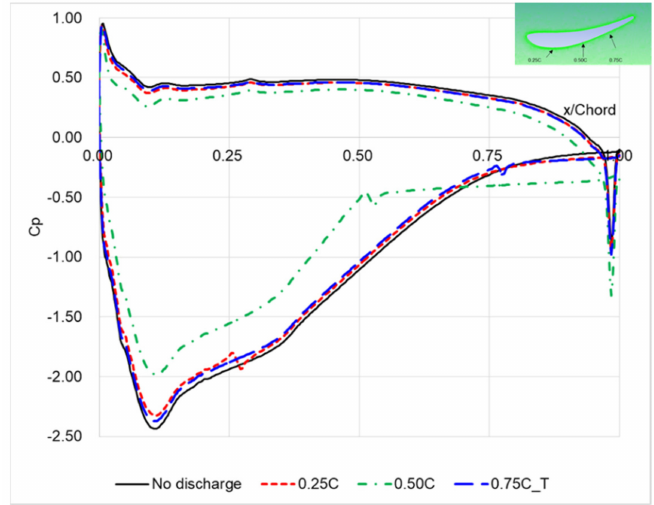
Figure 8. Comparison of surface pressure distributions for various discharge positions at U = 300 km / h and Vb / U =